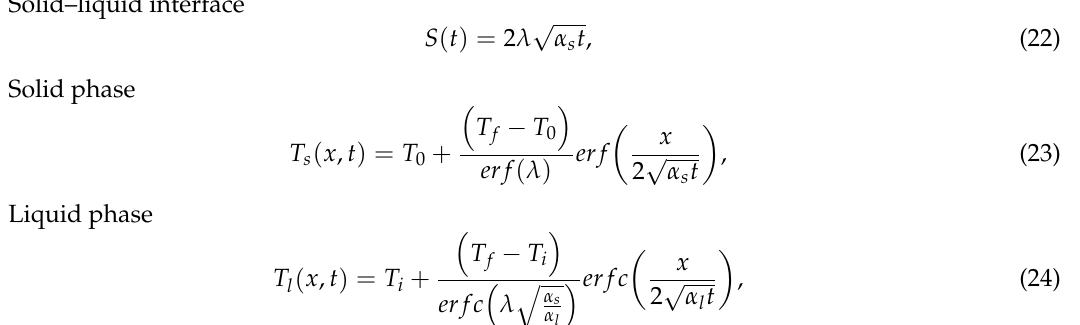
Figure 3. Diagram of heat conduction problem with phase change in semi-infinite space .